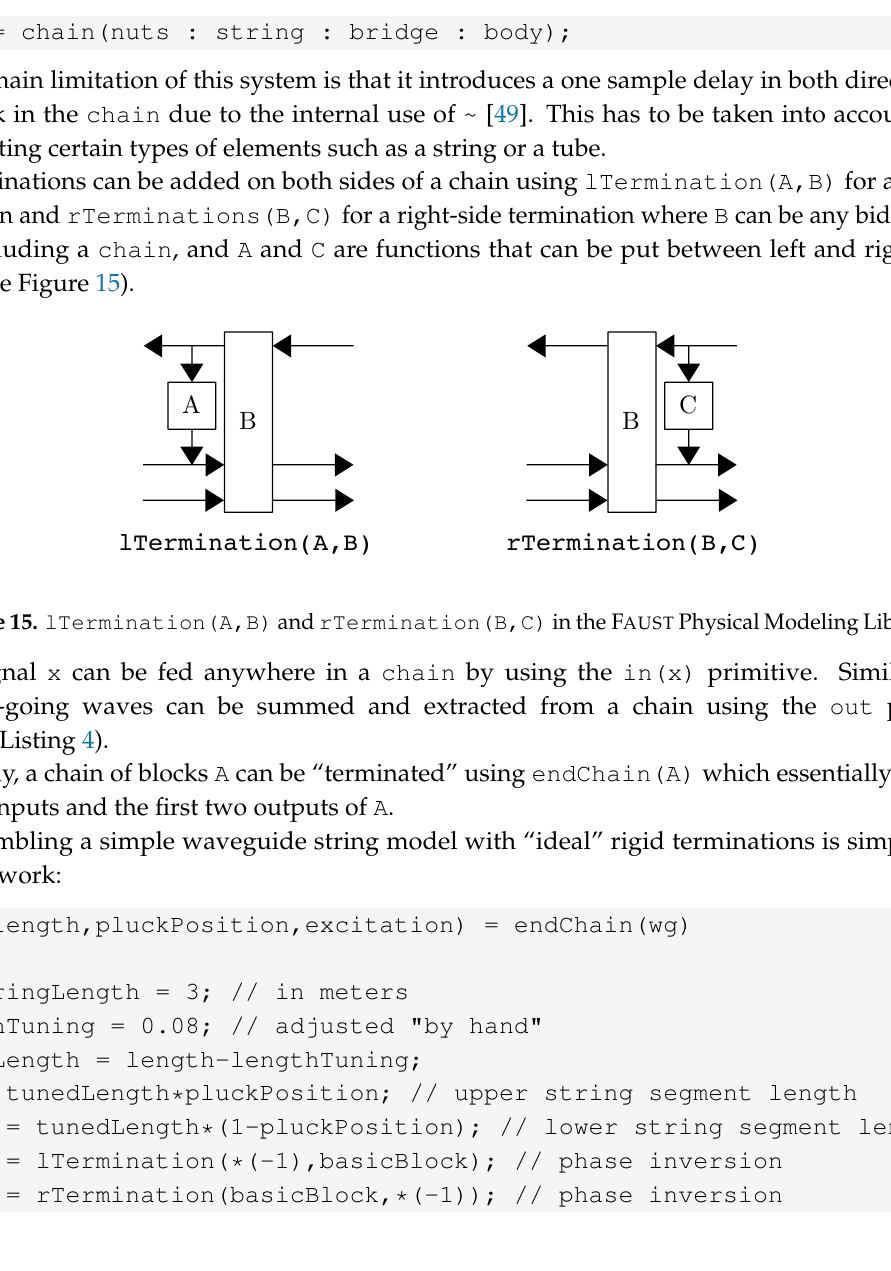
Figure 14. Bidirectional construction in F AUST using the chain primitive.